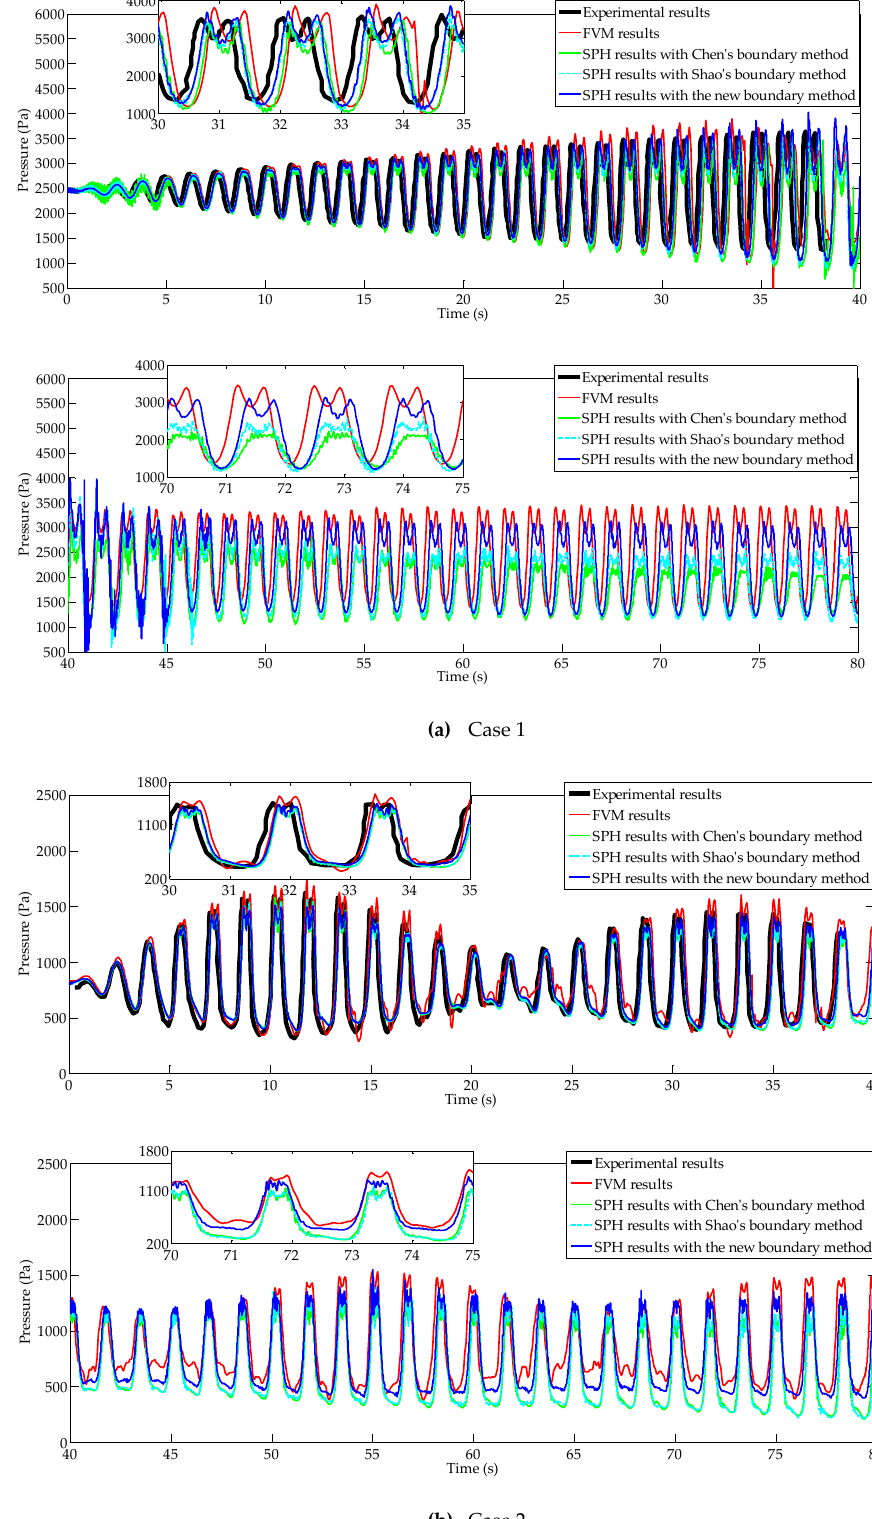
Figure 7. Pressure values at the pressure sensor obtained by the numerical simulations and experi- ment of ( a ) Case 1 and ( b ) Case